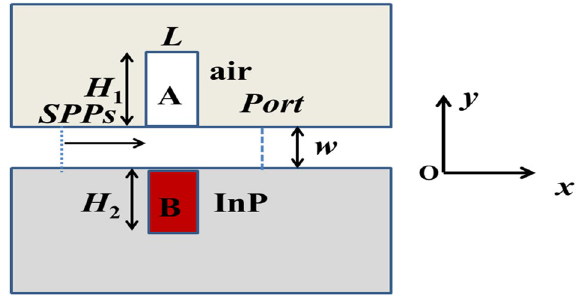
Figure 1. Research scheme and design schematic of 2D simulation. The capital letters A and B denote air and InP coupled cavities, respectively. The structural parameters were L = w = 50 nm.